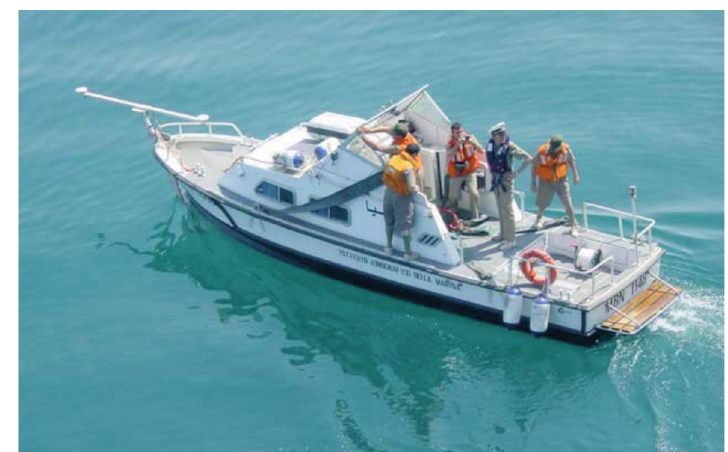
Fig. 4. Small hydrographical GRP